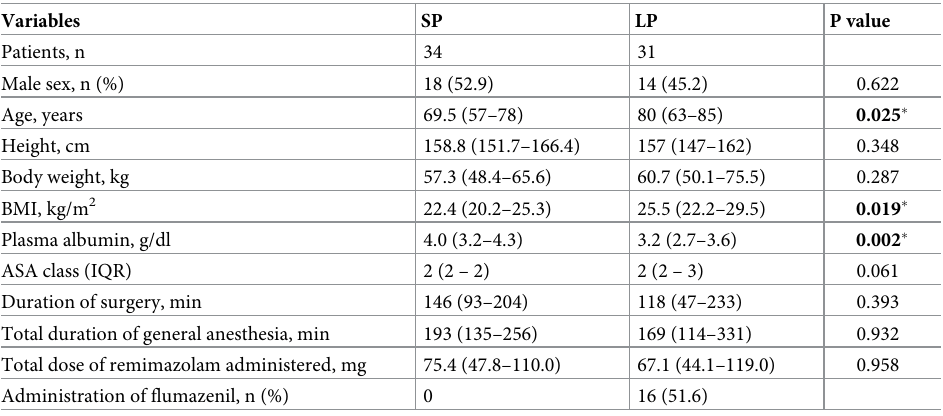
Table 1. Clinical characteristics of patients in LP and SP